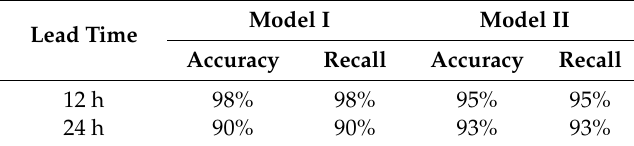
Table 3. Forecasting performance in terms of accuracy and recall (training